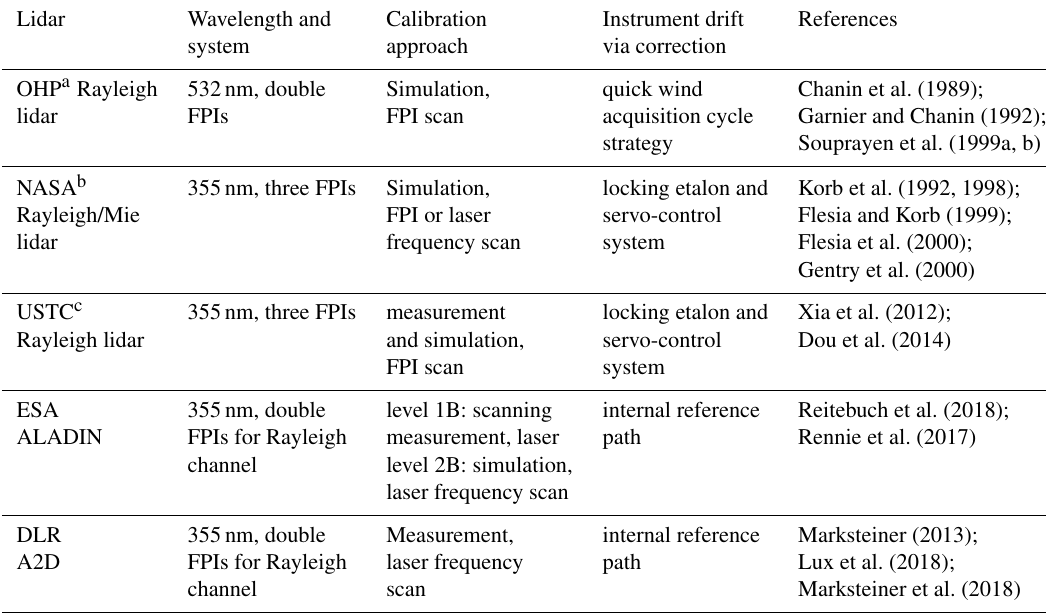
Table 1. Comparison of different FPI-based direct-detection wind lidars.